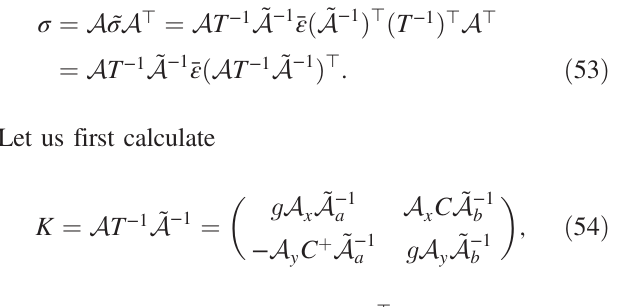
FIG. 4. The same parameters that are shown in Fig. 3 but with an additional steering error at injection X 2 ¼ 1 . The slow decrease of motivates the extended range of